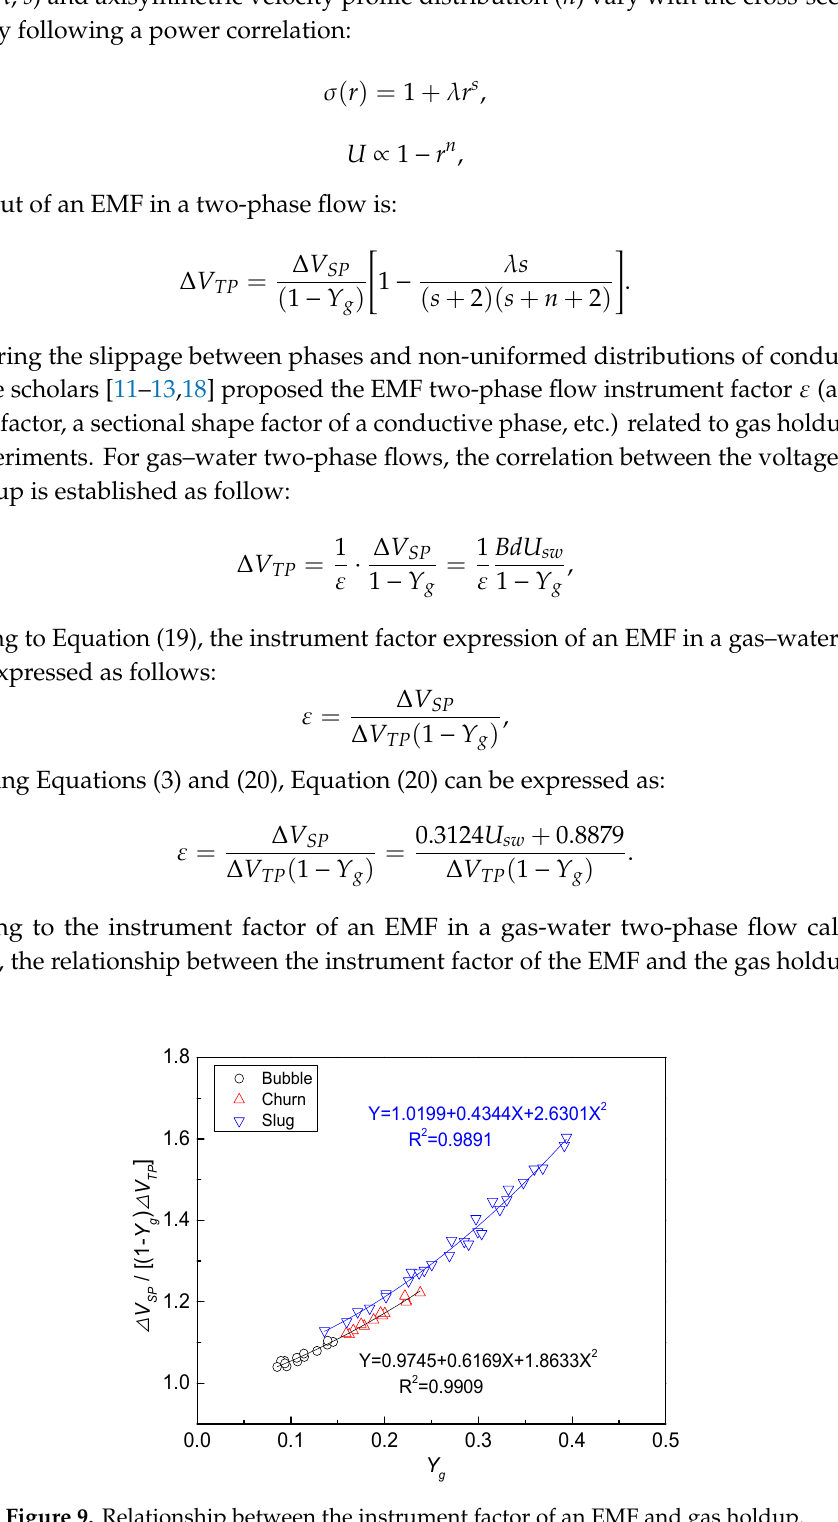
Figure 9. Relationship between the instrument factor of an EMF and gas holdup.